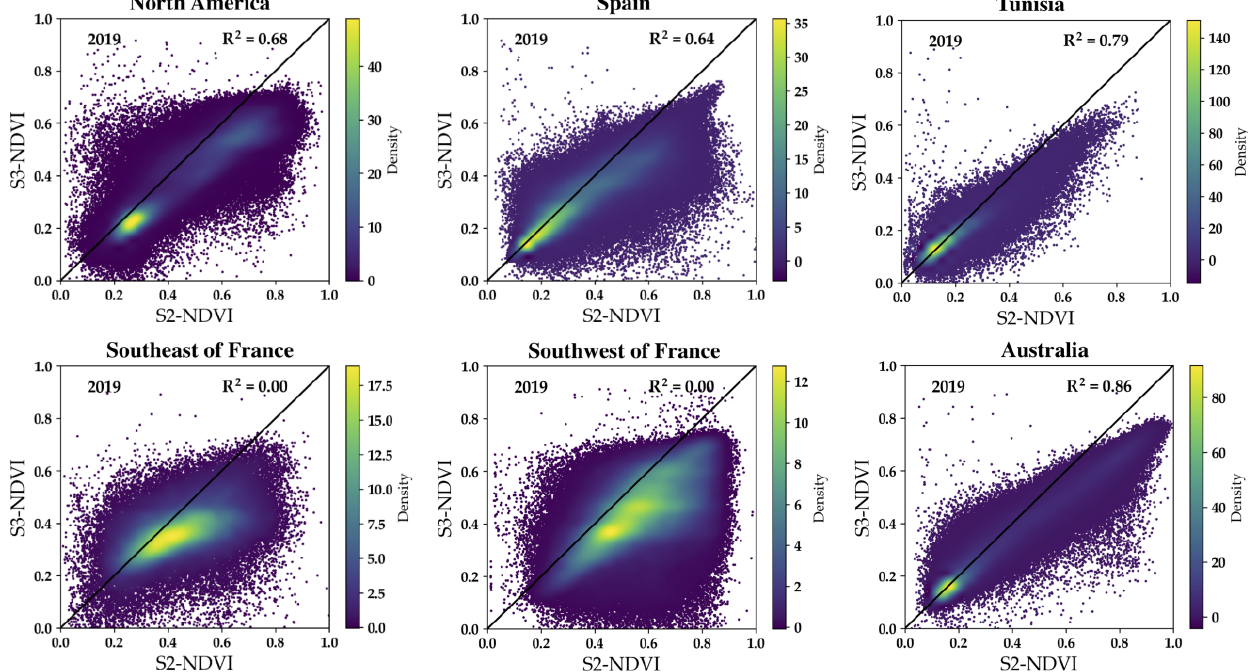
Figure 2. Correlation between S2 and S3 NDVI at 1km grid scale for the six study regions from January to December 2019.